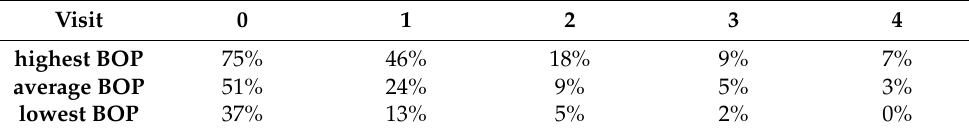
Table 2. Percentage results of BOP index after repeated injections.